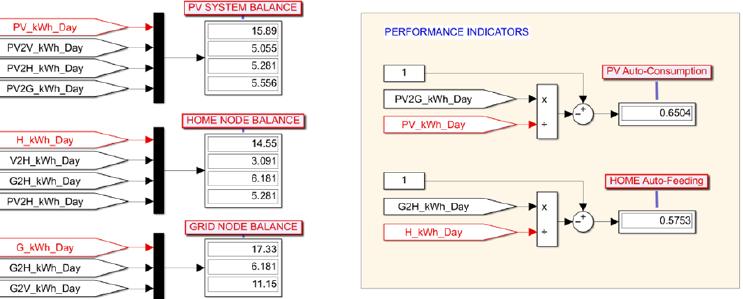
Figure 22. Energy balances at the main nodes ( left ) and performance indicators ( right ) for Case4—AW 2D.